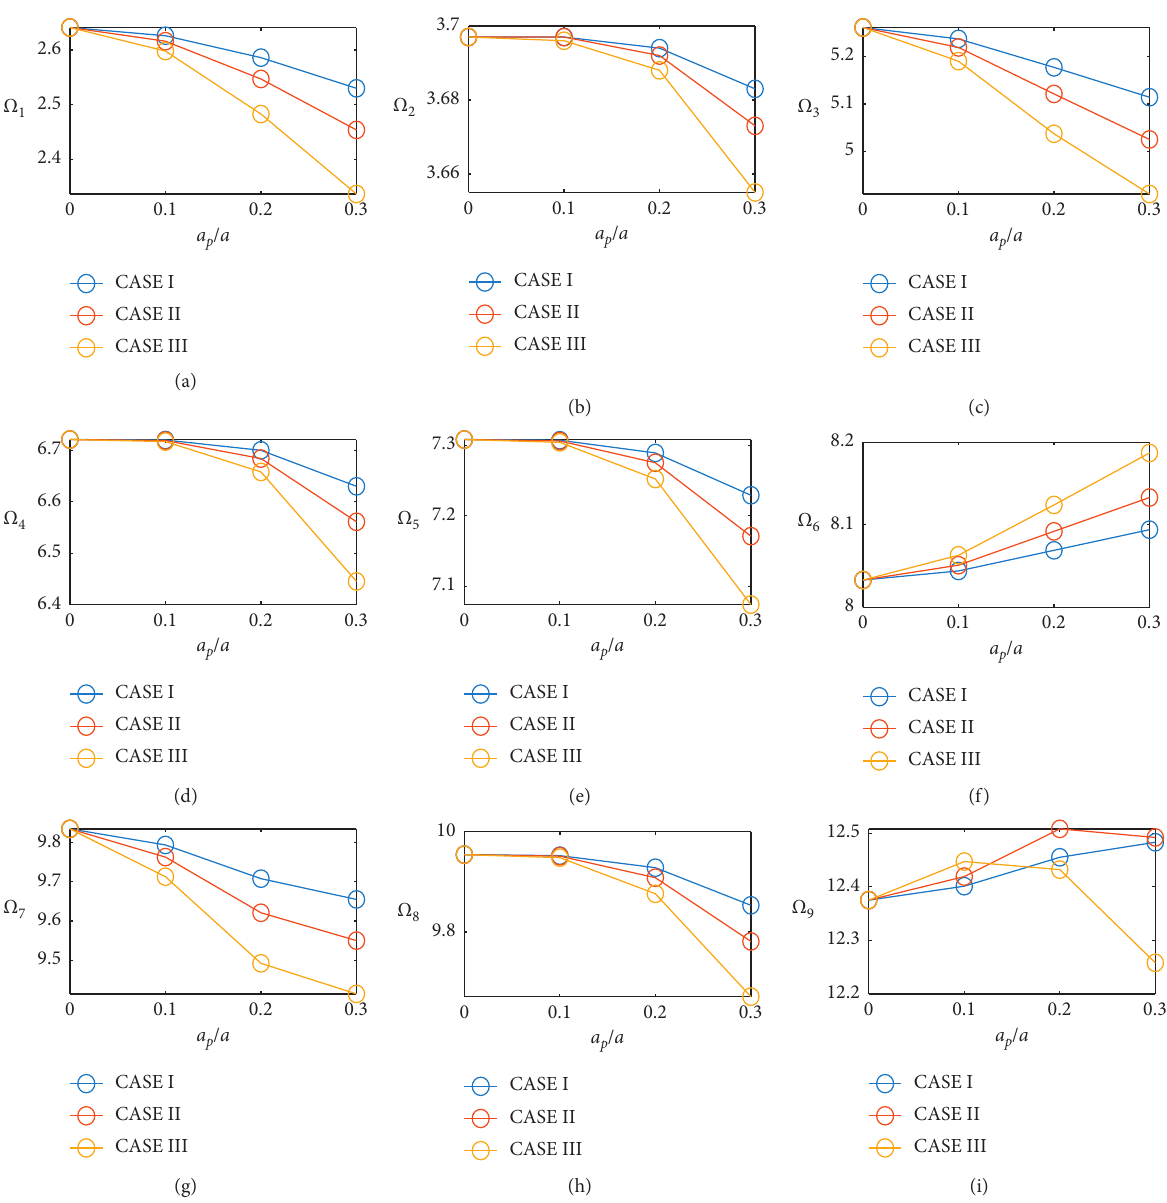
Figure 6: Nondimensional frequencies of the angle-ply laminate ([45/ − 45]s) with CCCC boundary condition, E 1/ E 2 � 10, a � 2b, and b � 10h and for different patch sizes and